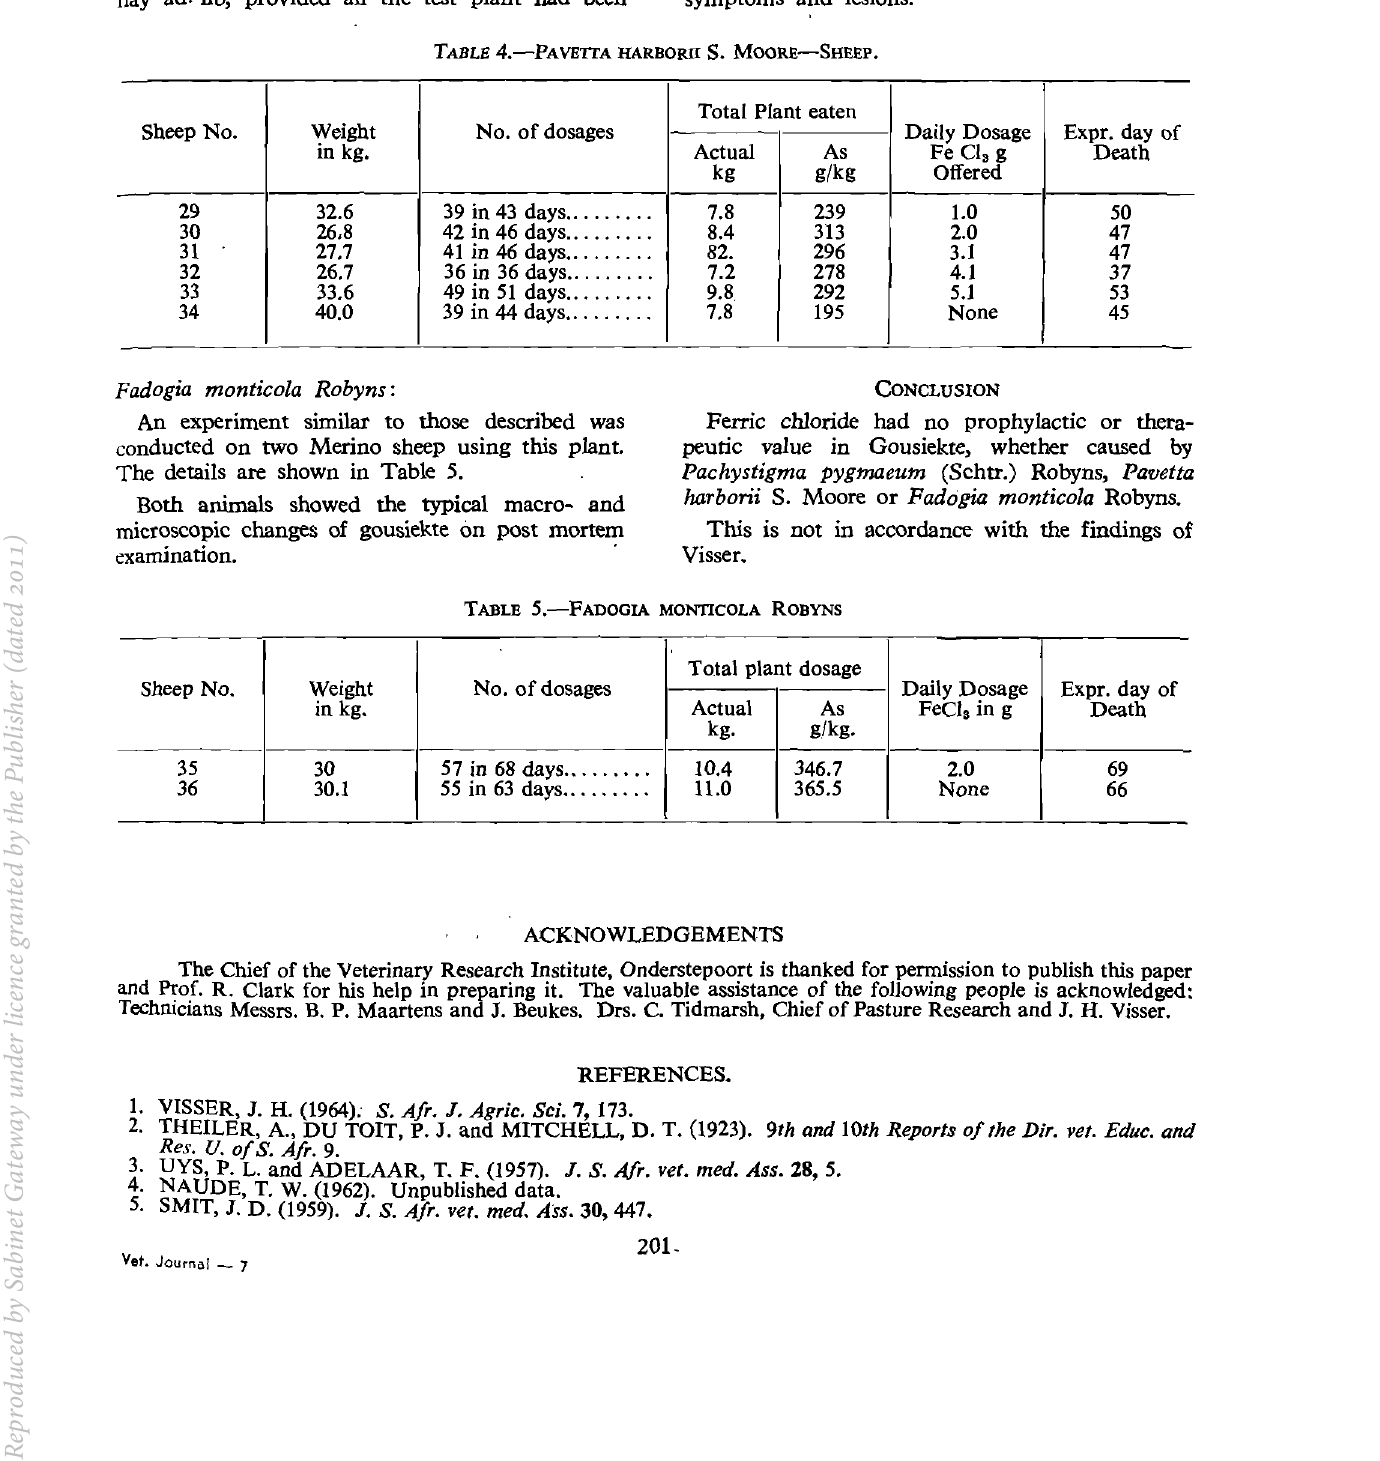
TABLB 4.-PAVB'ITA HARBORll S. MOORE-SHEEP.